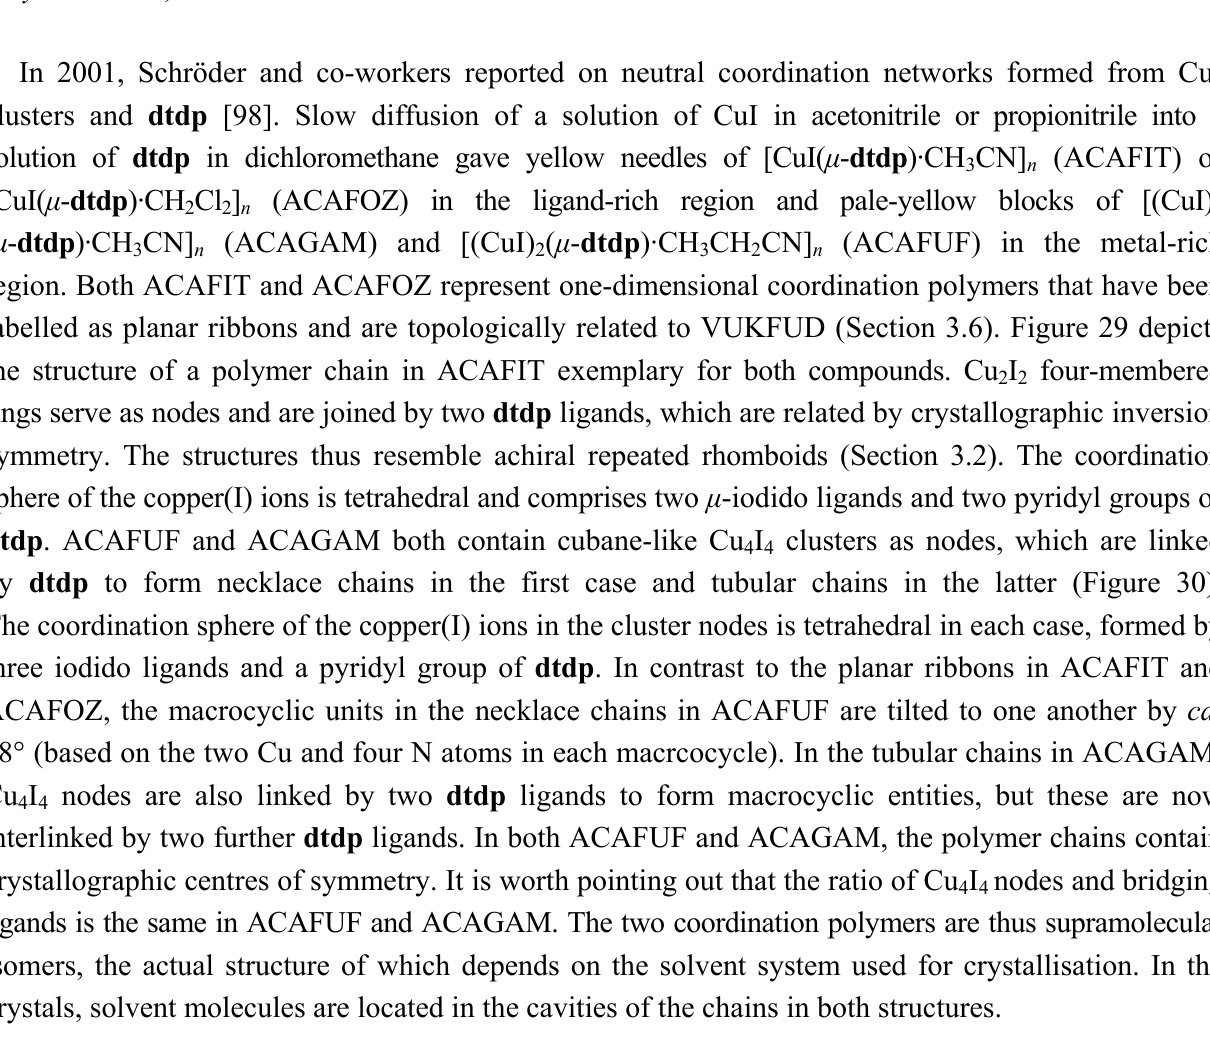
CN] (ACAFIT), resembling 3 n